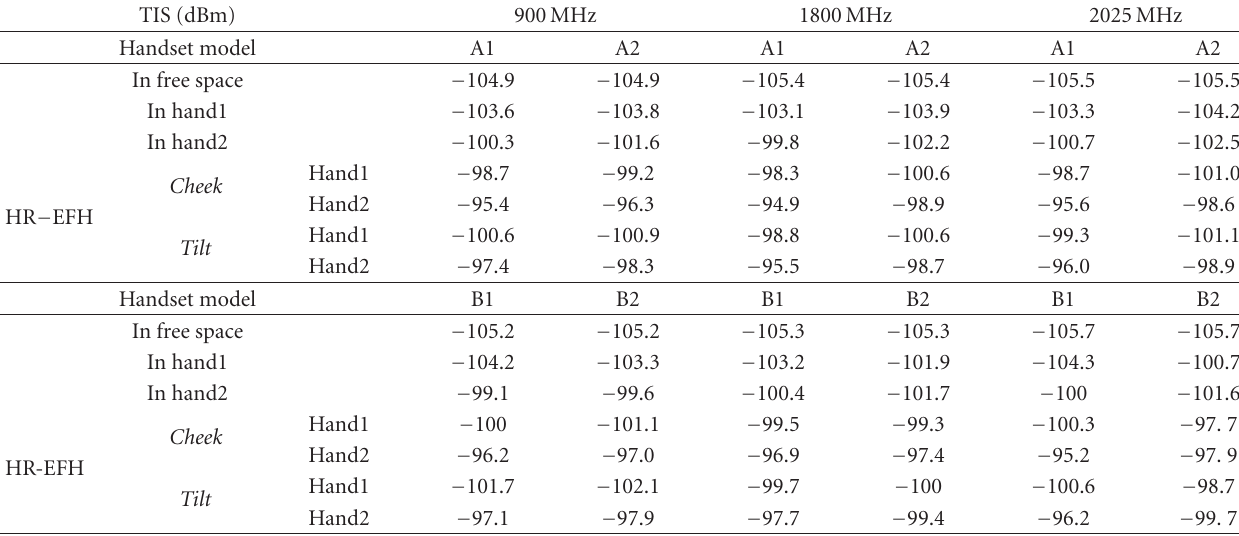
Table 7: The total isotropic sensitivity (TIS) levels of the handset models for di ff erent setups at 900, 1800, and 2025 MHz.